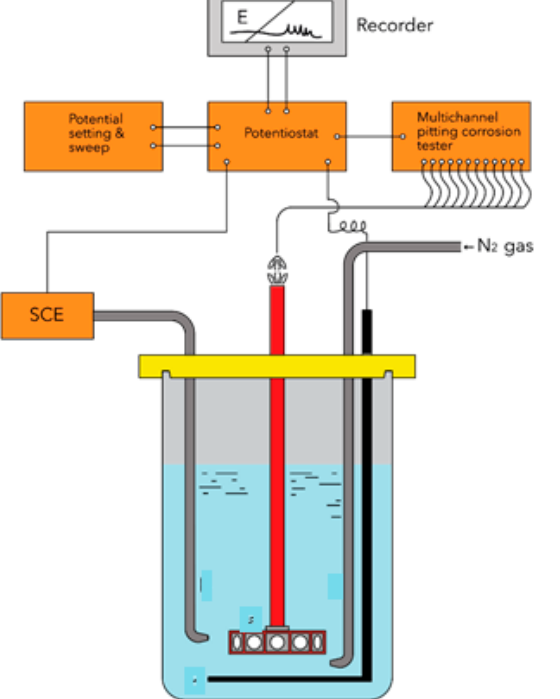
Figure 2. Illustration of the multichannel pitting corrosion testing device. Adapted and turned into color according to the scheme given in Figure 1 of reprinted with permission from ref. [52]. Copyright 2022 CORROSION.